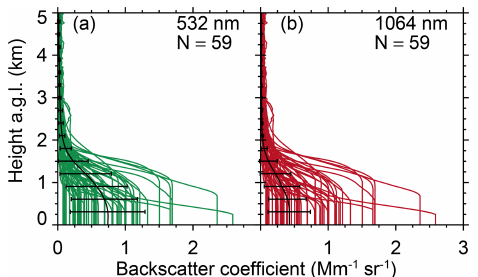
Figure 14. Single (coloured lines) and averaged (black lines) height profiles of the particle backscatter coefficients at 532nm (a) and at 1064nm (b) as derived from Polly XT observations. The error bars indicate the standard